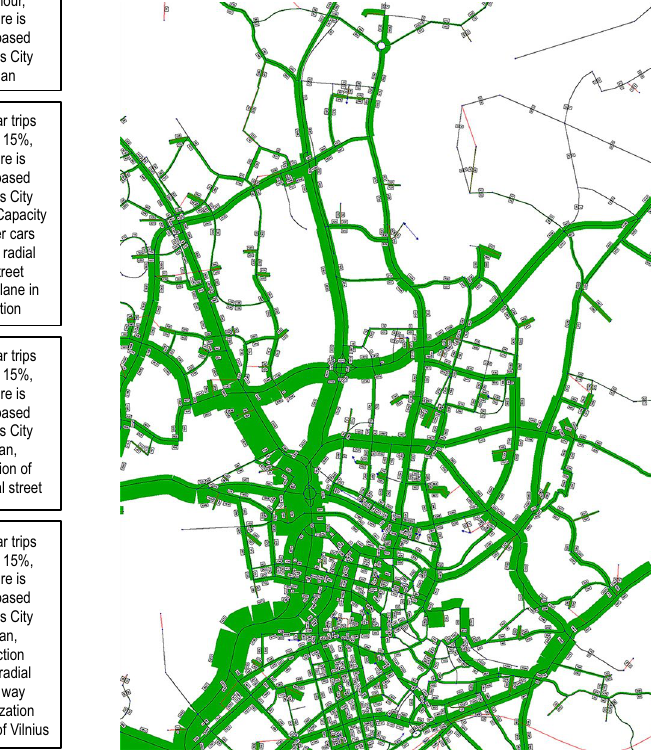
Fig. 5. The modelled scenarios